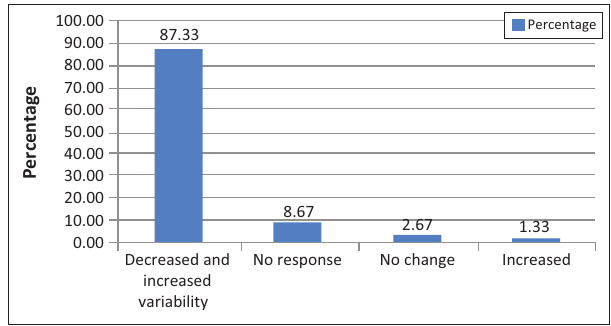
FIGURE 1: Perceptions of changes in rainfall patterns.